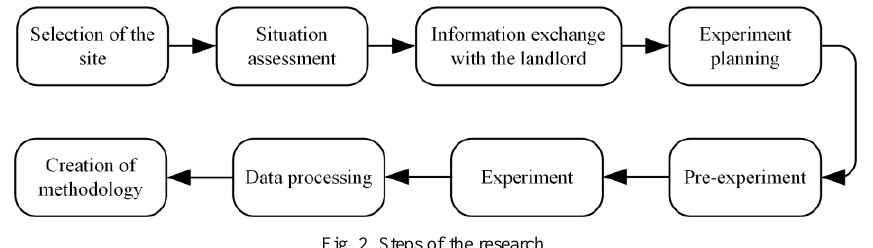
Fig. 2. Steps of the research.